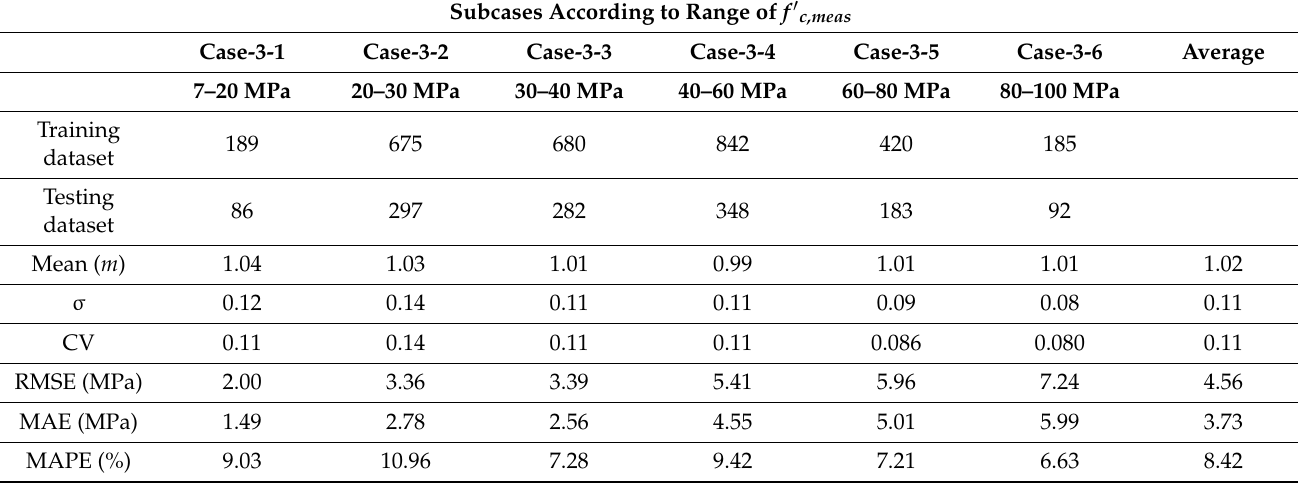
Table 4. Analysis accuracy of ML trained with data in each